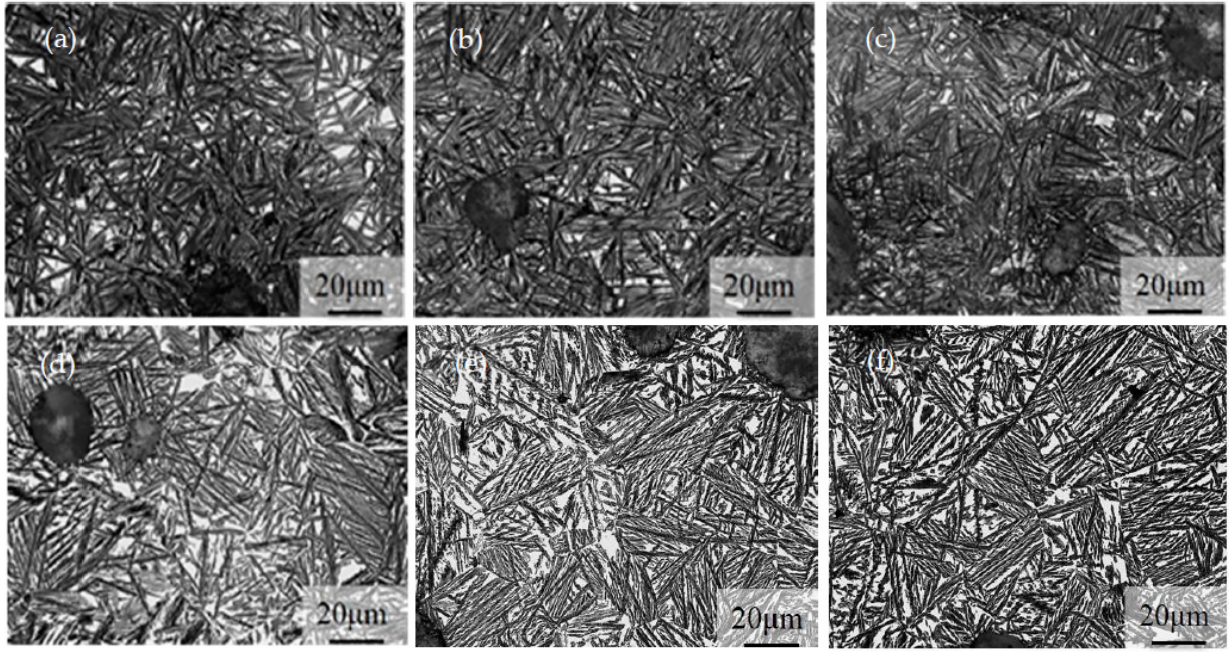
Figure 3. Microstructures of the ADIs: (a) 300 − 1 h, (b) 300 − 5 h, (c) 300 − 10 h, (d) 360 − 1 h, (e) 360 − 5 h, and (f) 360 − 10 h.